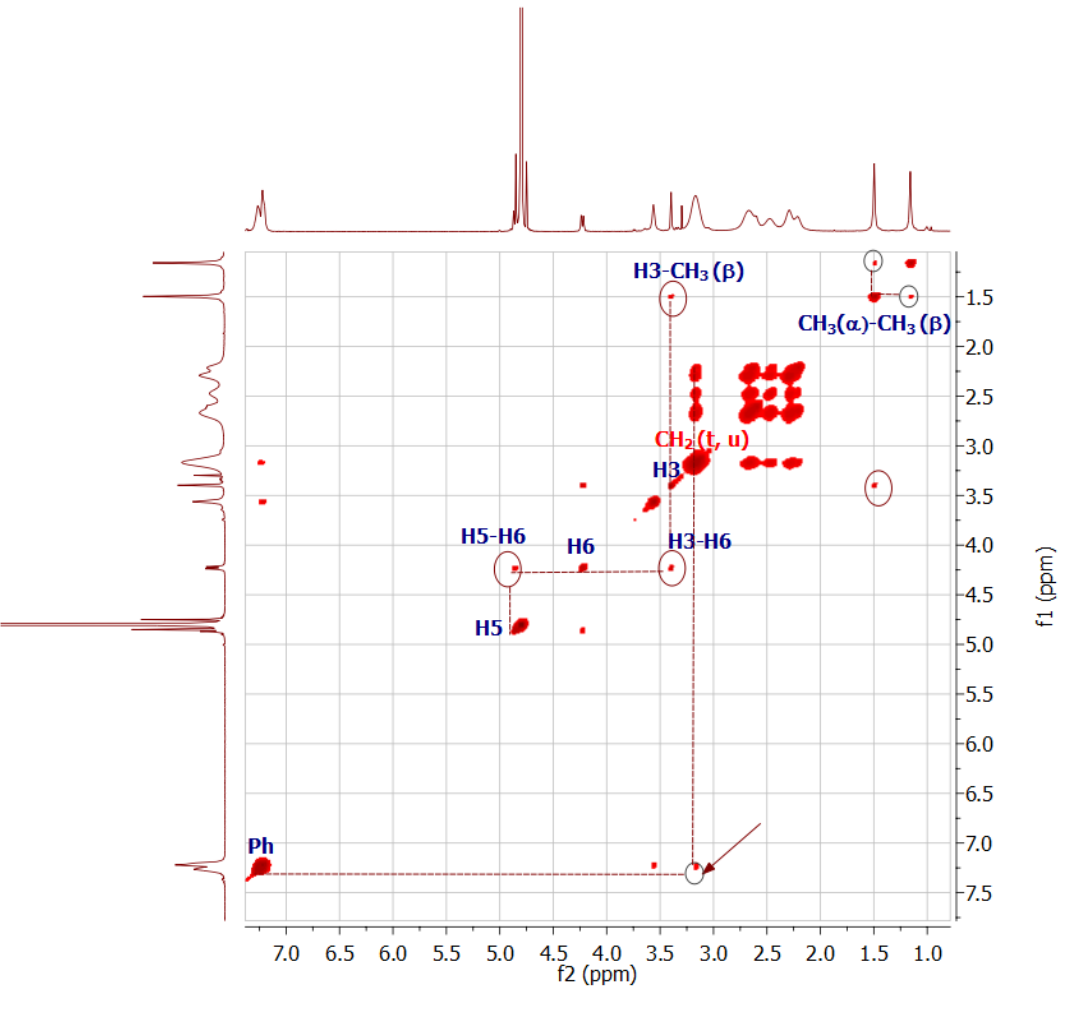
Figure 5. 2D-NOESY spectra of G protons corresponding to the benzylpenicilloyl units and those in the dendritic